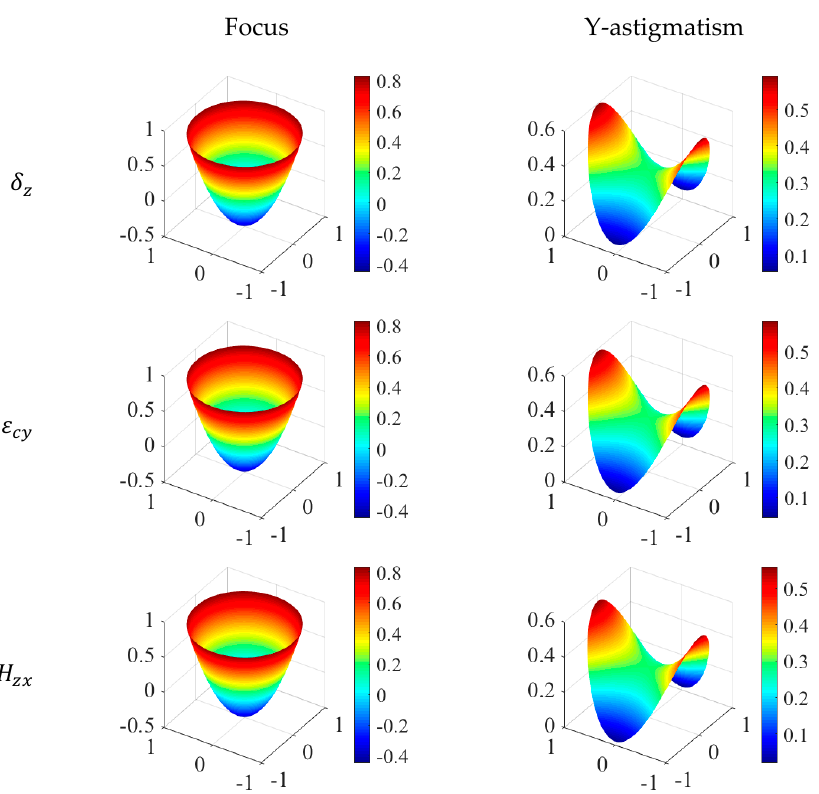
Figure 4. The focus map and the Y-astigmatism map under the influence of errors δ z , ε cy and H zx .